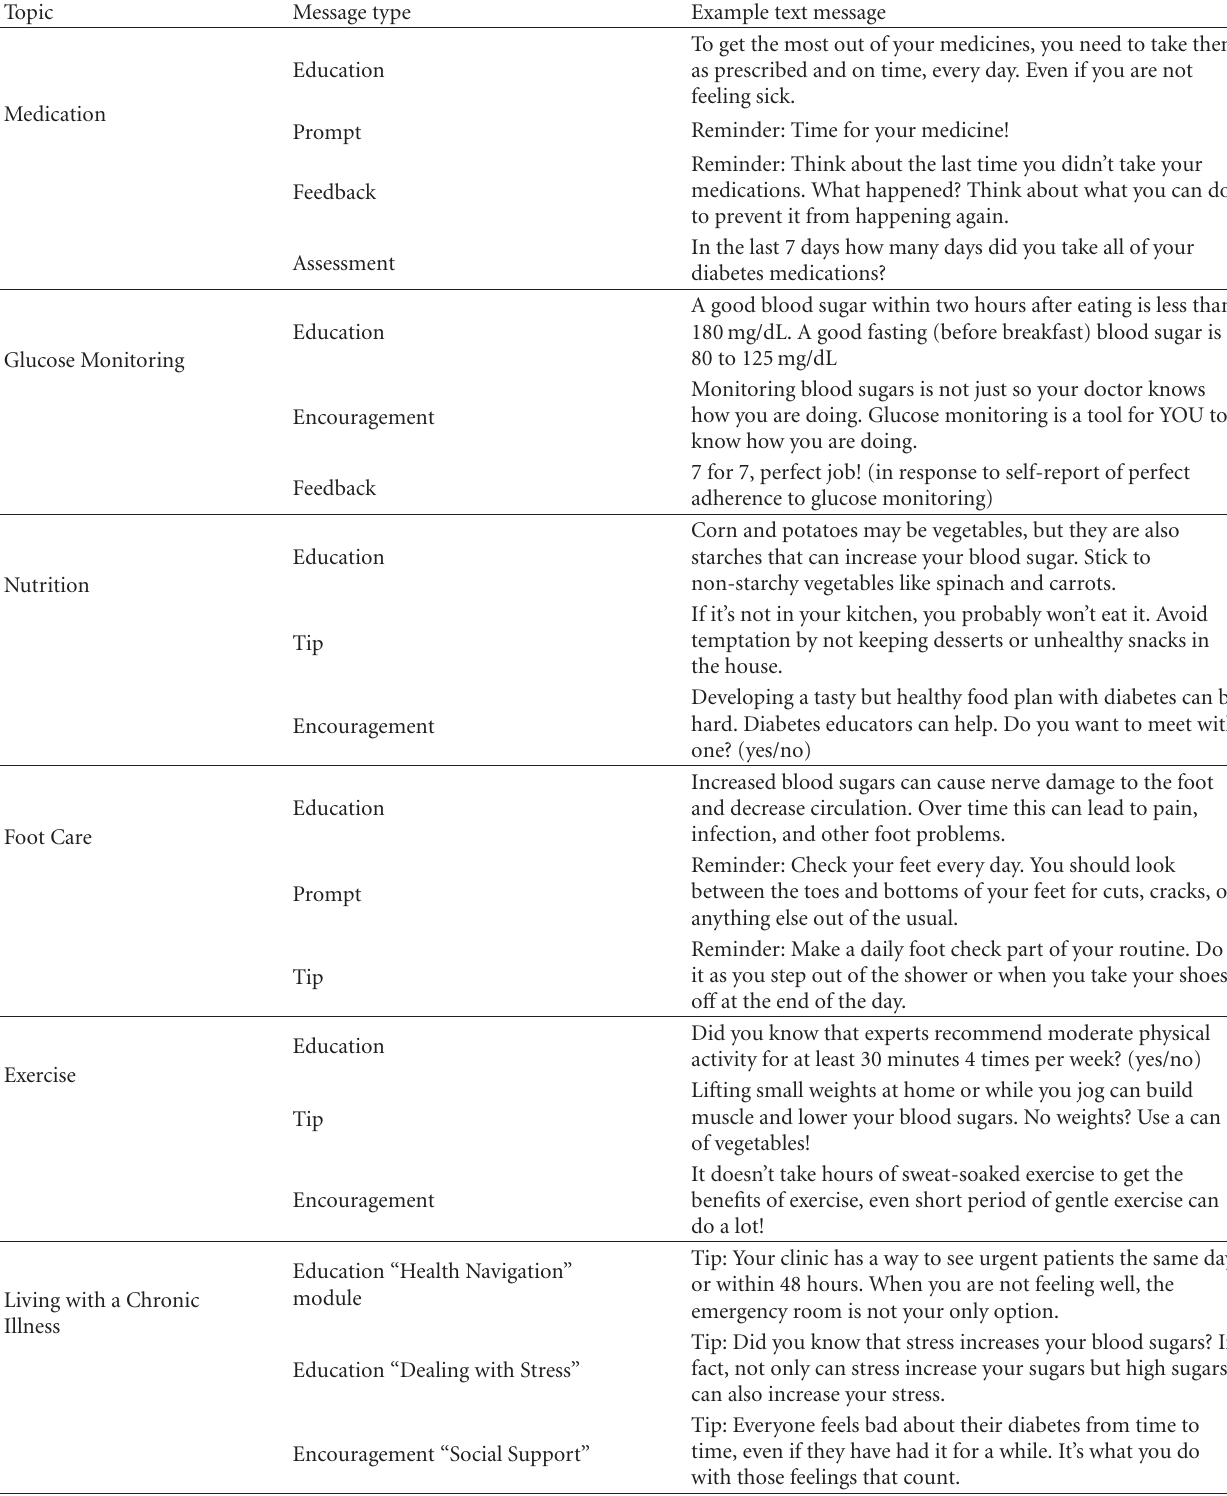
Table 1: Representative text messages across various topics and message types. Note that all five message types are used for each topic area. This table gives examples of some of these types for each